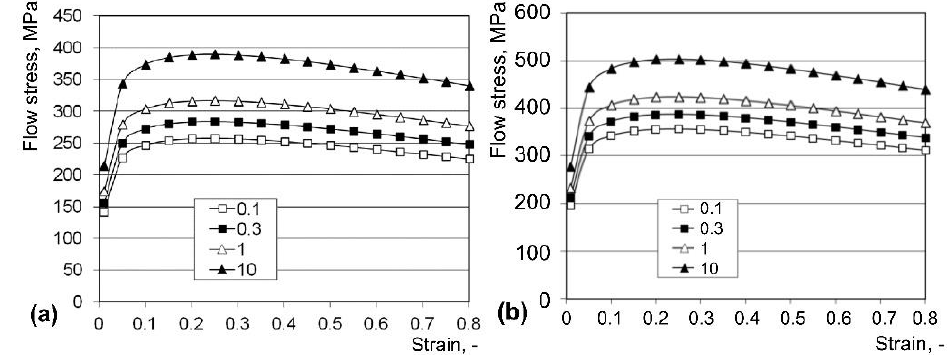
Figure 1. Results of the experimental study of the initial wire: ( a ) microstructure (light microscope); ( b ) example surface profile in the longitudinal direction; ( c ) crystallographic textures of initial wire (the inverse pole figure). Figure 2. Stress – strain curves of CuZn37 alloy for 400 °C ( a ), 350 °C ( b ), and different strain rates (0.1 – 10 s − 1 ).